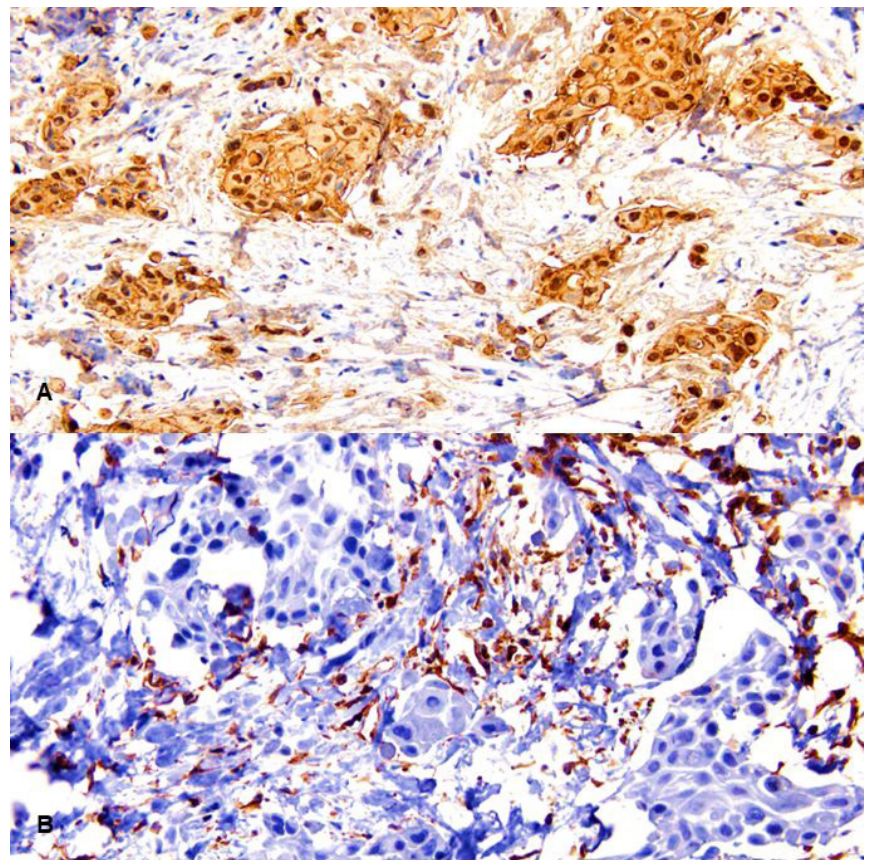
Figure 2. Photomicrographs of immunohistochemical features of extra-hepatic cholangiocarcinoma in an adult Black Howler Monkey ( Alouatta caraya ). (A) Neoplastic cells with marked and diffuse immunostaining by the cytokeratin antibody in the cytoplasm and nuclei (200x); (B) Neoplastic cells labeled by vimentin antibody, note positive cells in the neoplastic stroma. Streptavidin-Biotin Peroxidase Complex